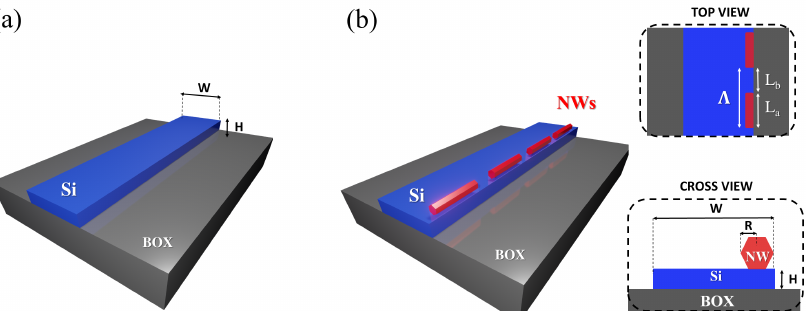
Figure 1. ( a ) Three-dimensional (3D) illustration of a silicon on oxide waveguide structure. ( b ) The same waveguide reported in ( a ) is represented with the addition of NWs. In the right panel, we illustrate the device with additional 2D top and cross